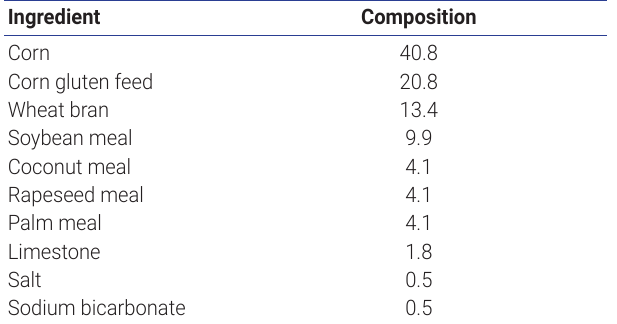
Table 3. Chemical composition of feeds used in the palatability test (g/kg DM, unless otherwise stated) Composition SQ